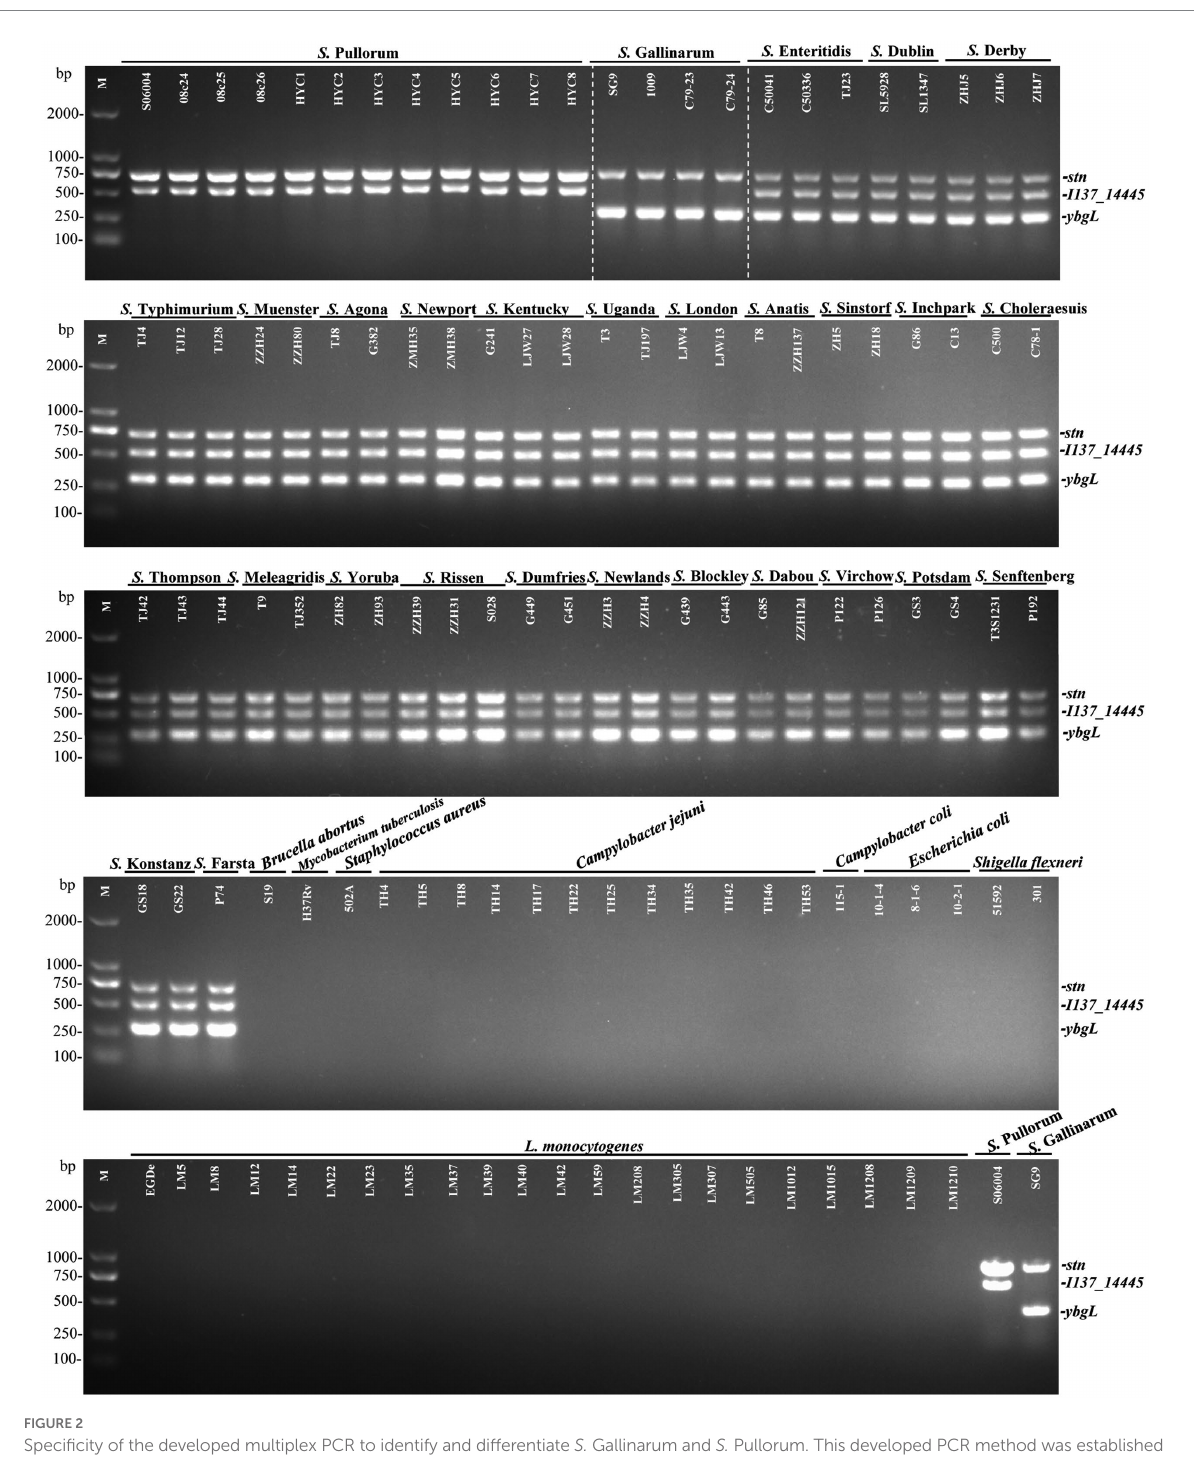
FIGURE 2 Specificity of the developed multiplex PCR to identify and differentiate S. Gallinarum and S. Pullorum. This developed PCR method was established on three specific targets: stn (731 bp), I137_14445 (525 bp), and ybgL (307 bp). The PCR specificity was determined with extracted genomic DNA from 12 strains of S. Pullorum, 4 strains of S. Gallinarum, 59 strains of other Salmonella serovars, and 43 strains of non- Salmonella pathogens. Two specific PCR products for the stn and I137_14445 genes could be amplified in S. Pullorum, while only products from the stn and ybgL targets could be generated in S.